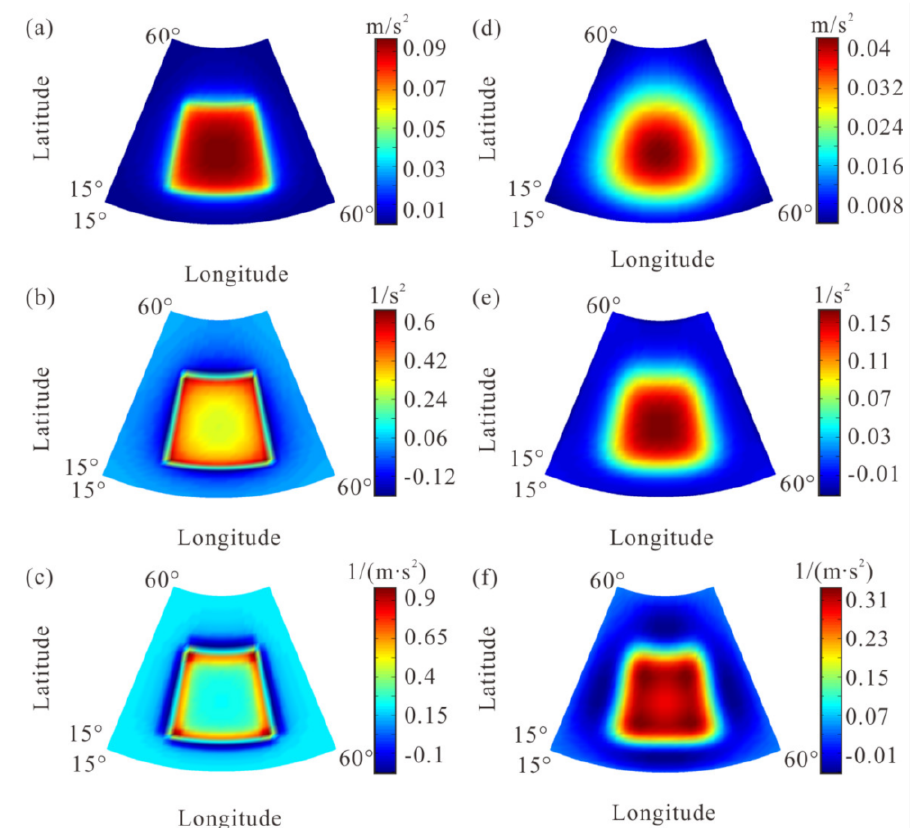
Figure A6. ( a ), ( b ) and ( c ) are gravity anomaly, the first-order radial derivative and the second-order radial derivative at r 0 = 5000 km; ( d ), ( e ) and ( f ) are gravity anomaly, the first-order radial derivative and the second-order radial derivative at r 0 = 6000 km.